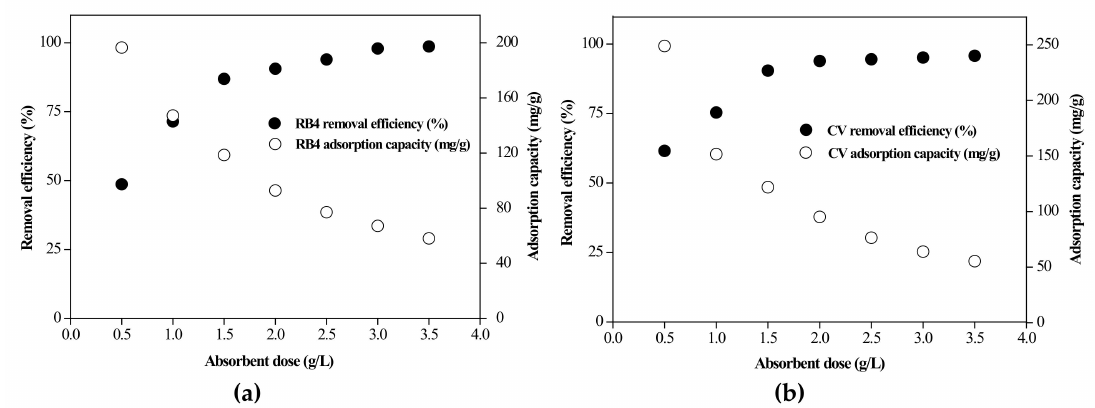
Figure 6. E ff ect of adsorbent dosage on the removal of ( a ) RB4 and ( b ) crystal violet